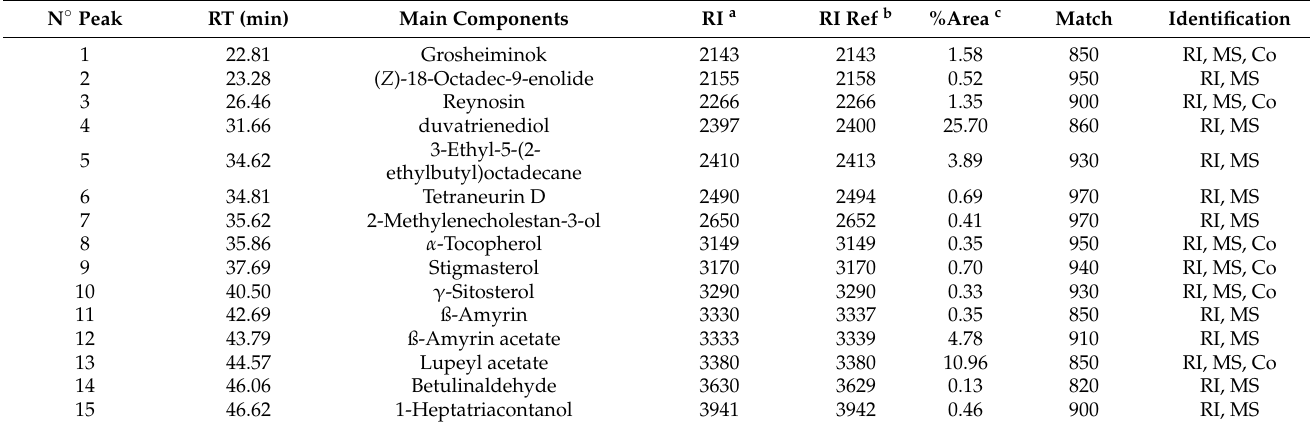
Table 1. Majority composition of Hex extract of L. rivularis flowers.